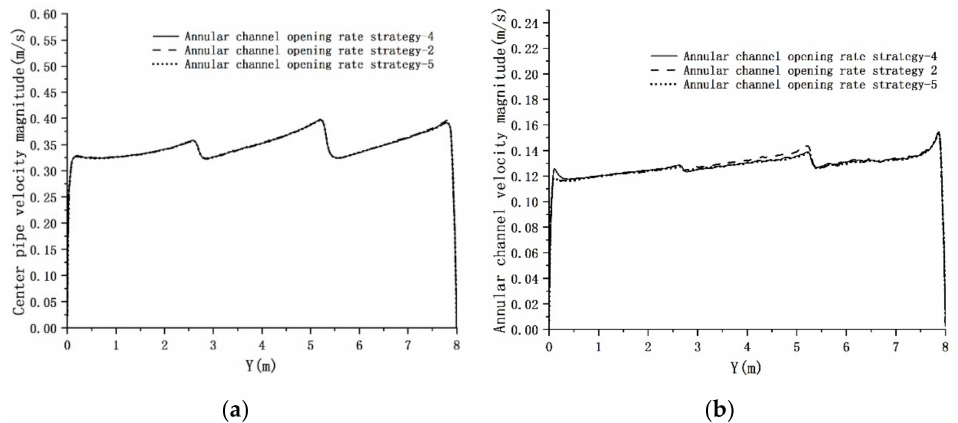
Figure 13. Radial velocity changes at different locations: ( a ) Radial velocity changes at the center pipe; ( b ) Radial velocity changes at the annular channel.